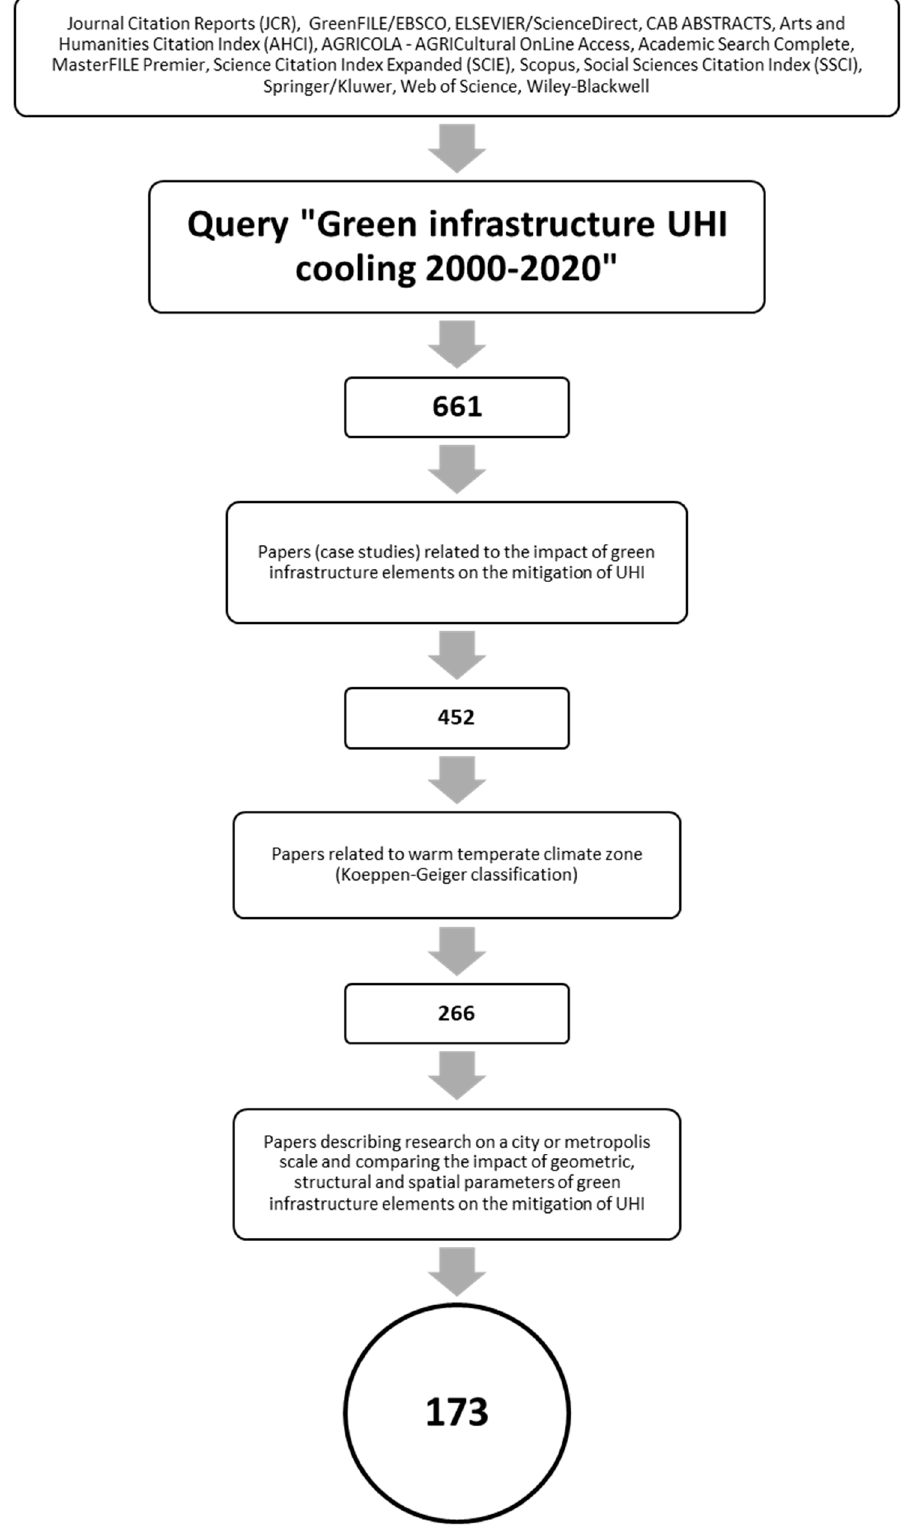
Figure 1. Logical diagram of papers selected for research.